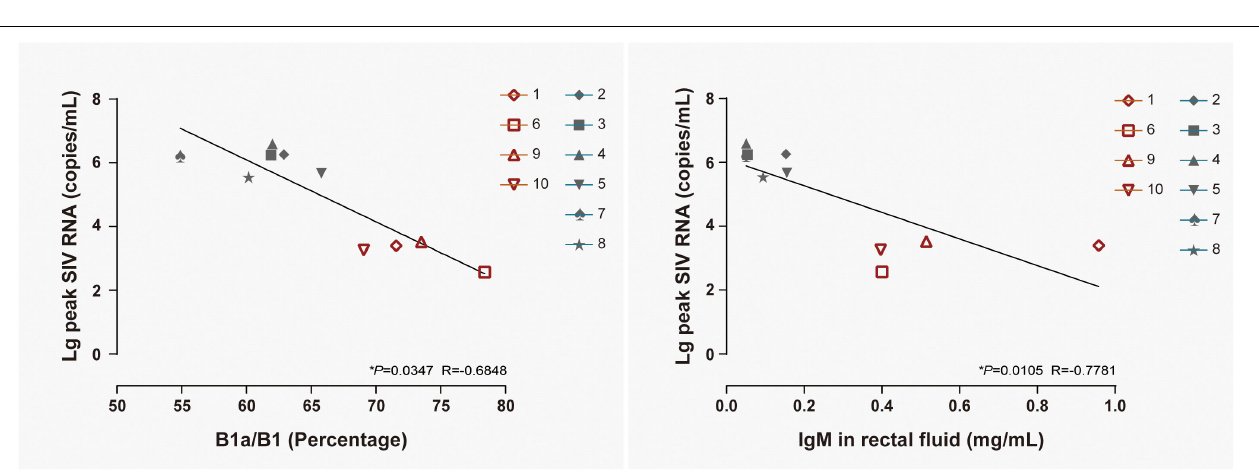
FIGURE 8 | Correlation of the B1a/B1 cell ratio among LPMCs and the IgM level in rectal fluid with peak viremia in 10 ChRhs. The correlations of peak viremia with the B1a/B1 cell ratio among LPMCs detected on day 11 post infection (left panel) and the level of IgM in rectal fluid detected at day 14 post infection (right panel) are shown. Using the Spearman correlation, strong significant linear correlations were observed between the B1a/B1 cell ratio and peak viremia ( R = − 0.6848) and between the level of IgM in rectal fluid and peak viremia ( R = − 0.7781) in 10 ChRhs with mucosal SIV exposure (* P <